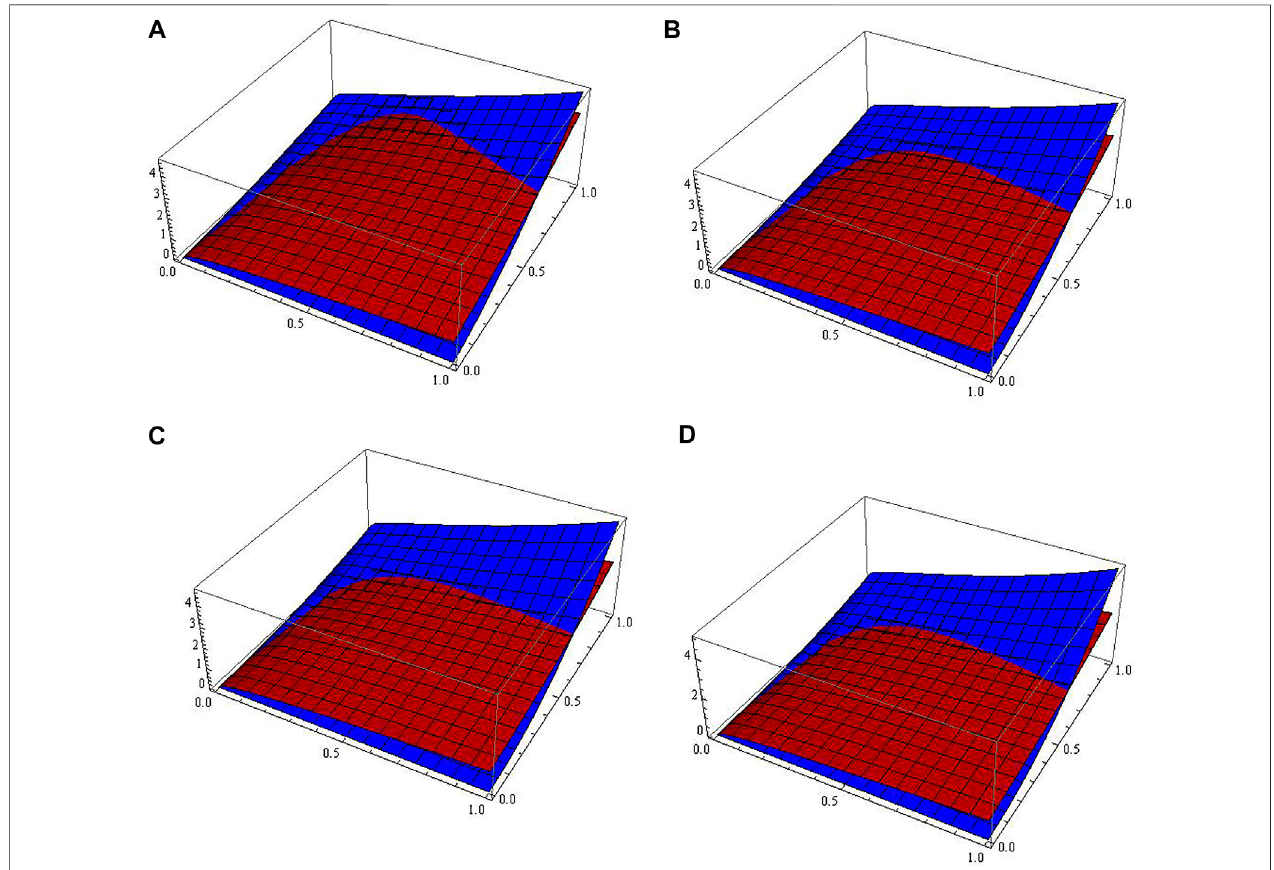
( x , t ) and U ( x , t ) in Eq. 72 for a fi xed value of β (cid:2) 0 . 5 and different 1 2